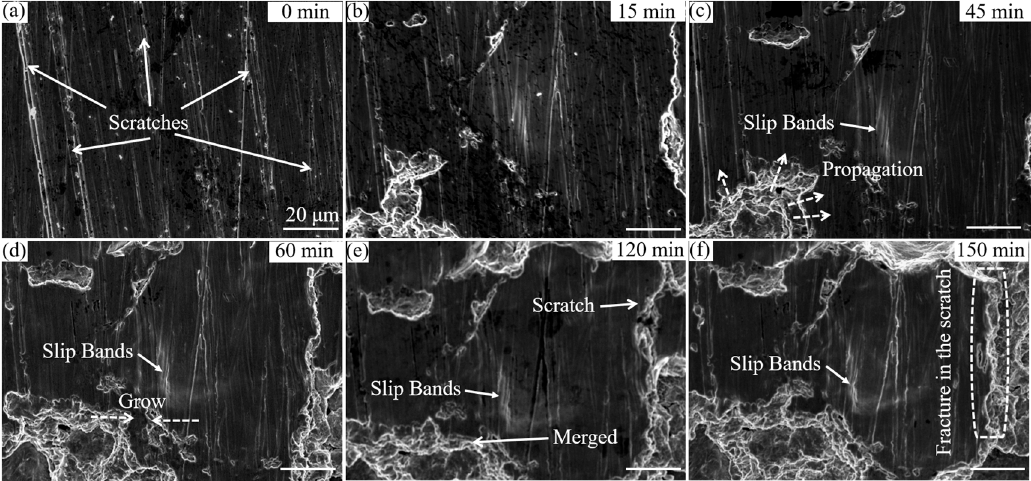
Figure 8. The microstructural evolution of the ground coating during the cavitation erosion process for ( a ) 0 min, ( b ) 15 min, ( c ) 45 min, ( d ) 60 min, ( e ) 120 min, and ( f ) 150 min.